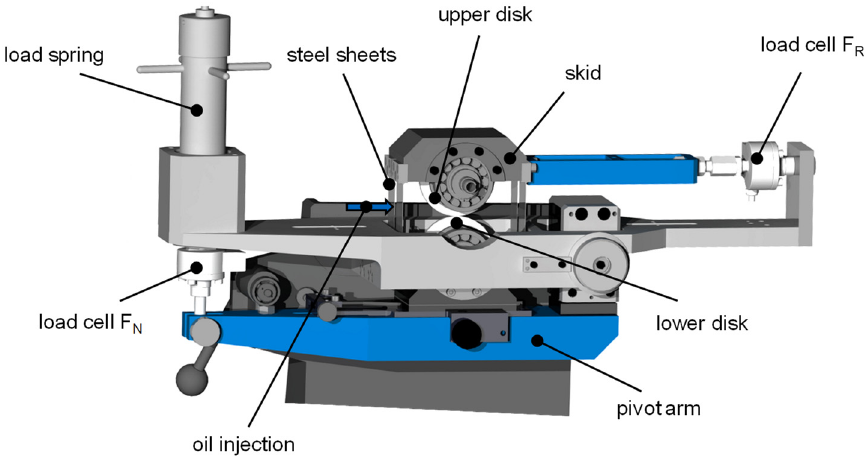
Figure 1. Schematic of the FZG twin-disk tribometer considered based on Ebner et al. Reprinted with permission from Ref. [21]. Copyright 2020 Elsevier.